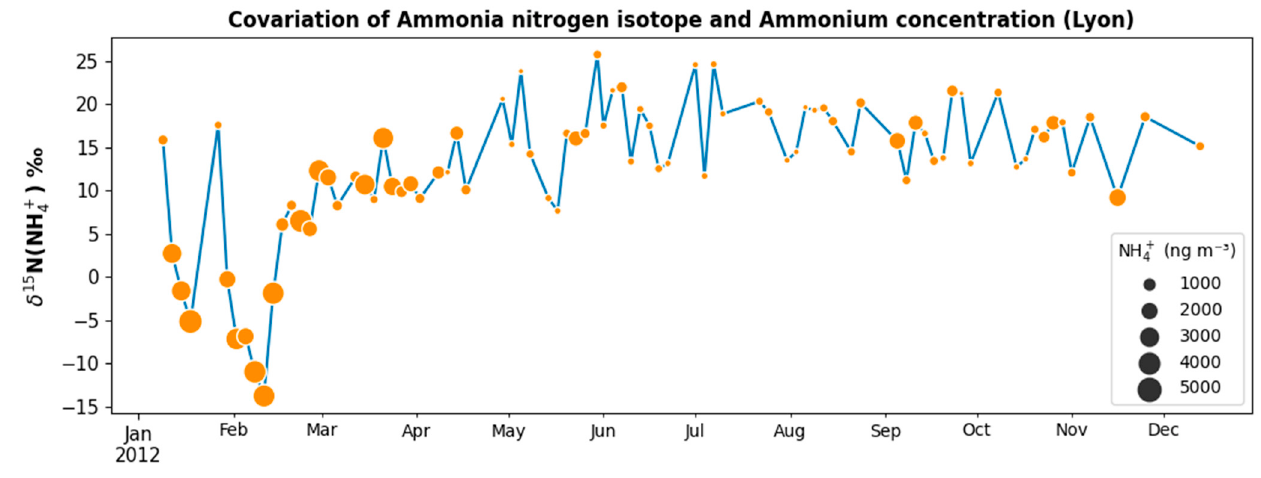
Atmosphere 2021 , 12 , x FOR PEER REVIEW Figure 16. δ 15 N and ammonium concentration time series in Lyon (urban background station, city center) in 2012.